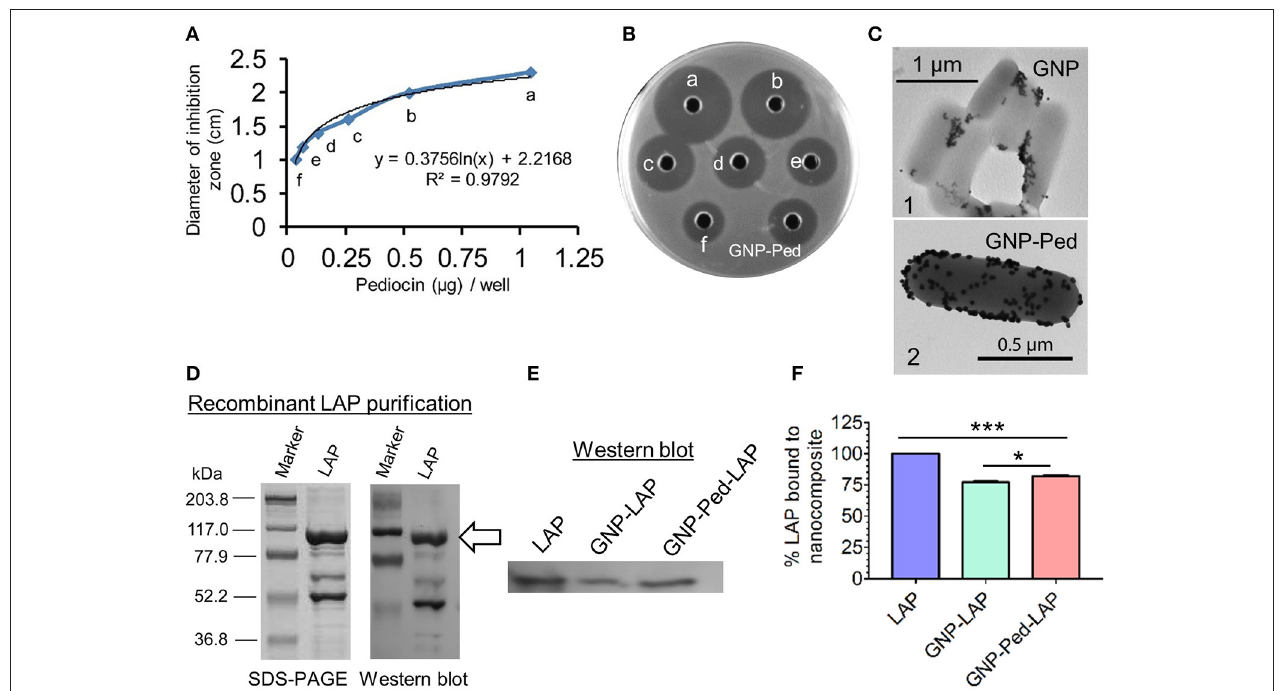
FIGURE 2 | Loading of Pediocin (Ped) and Listeria adhesion protein (LAP) on GNP. (A) The diameter of the zone of inhibition measured against indicator L. monocytogenes F4244 using known concentration of Pediocin in a bioassay on an agar plate (B) that helped in the estimation of Pediocin loaded on to GNP. Well labeled as GNP-Ped shows inhibition zone produced by Pediocin loaded on the GNP. (C) TEM shows the interaction of GNP (panel 1) and GNP-Pediocin nanoconjugate (panel 2) with L. monocytogenes cell. (D,E) SDS-PAGE and Western blot shows a single band of LAP molecule probed with a LAP-specific monoclonal antibody (indicated with arrow), which was quantified using ImageJ software (F) . Data are average of three independent experiments analyzed in duplicate. *** P < 0.001; * P <